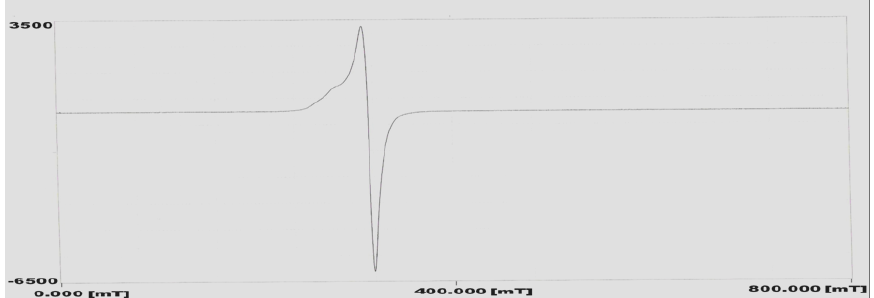
Figure 2. ESR spectra of copper